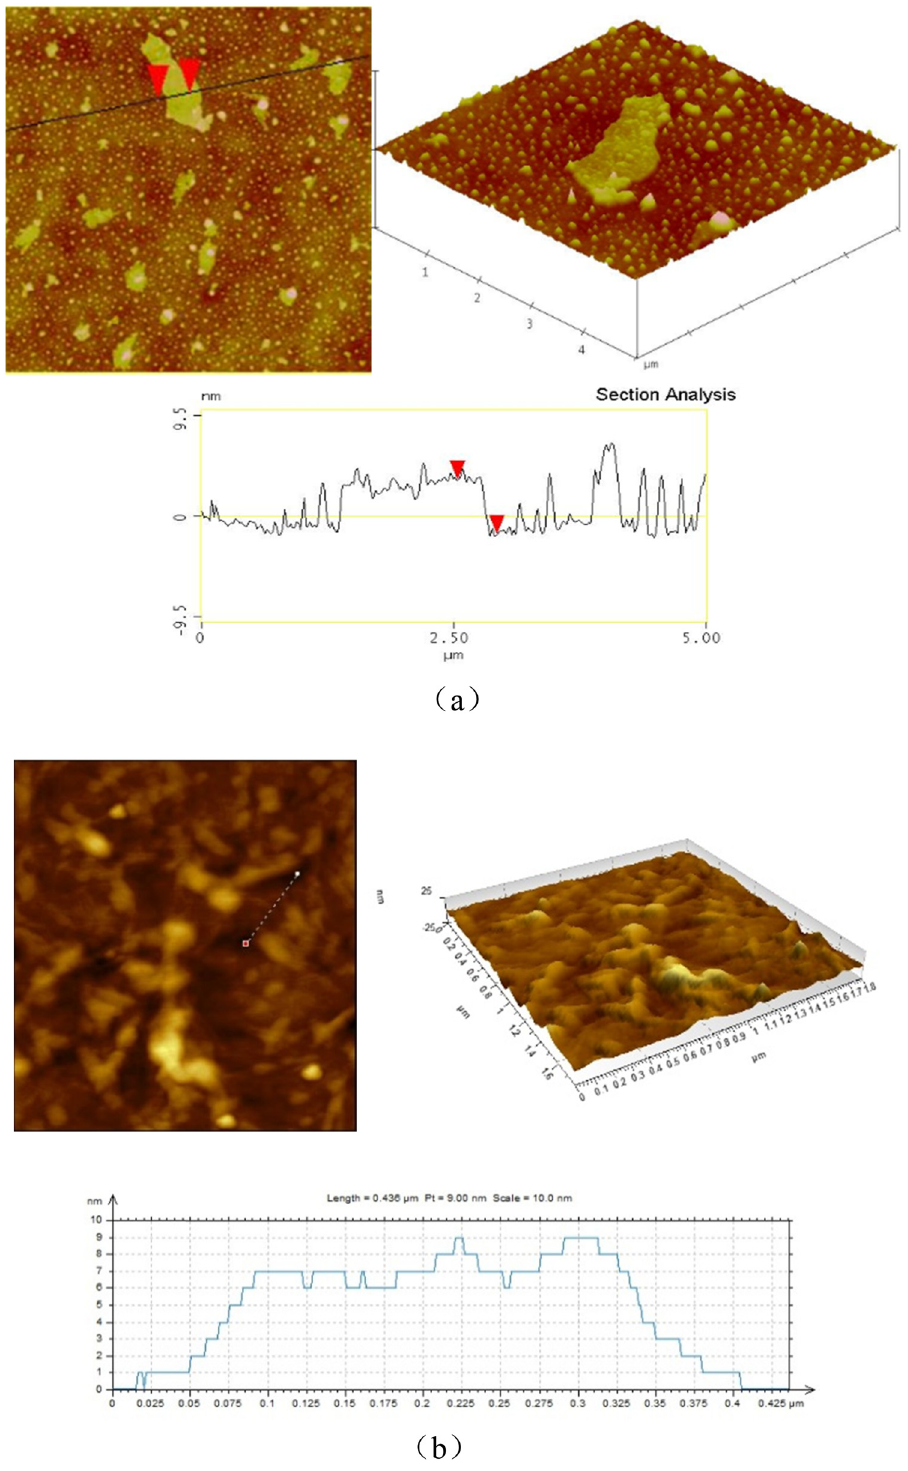
Figure 1: The AFM image of GO: ( a ) GO1 and ( b )